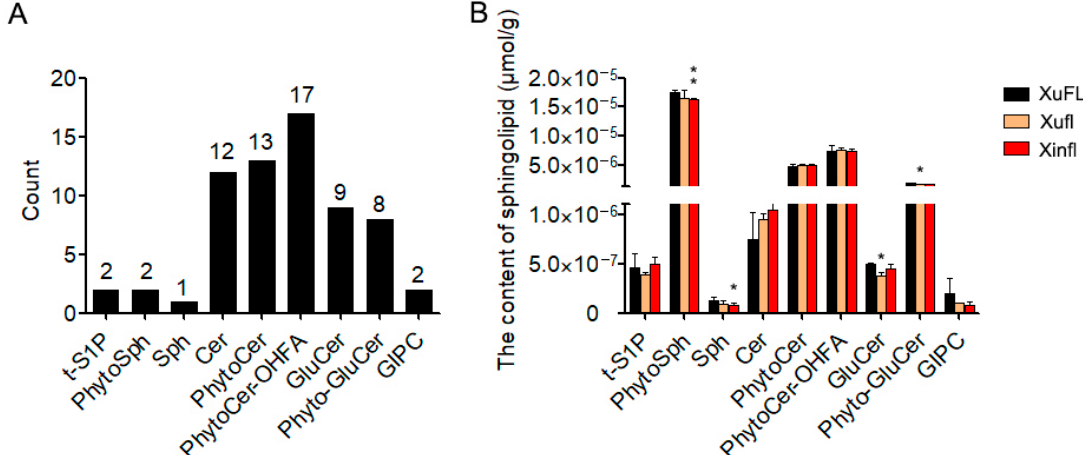
Figure 2. Sphingolipid classes in the 0-DPA ovules of cotton and their differences between wild-type and two mutants. ( A ) The number of classes and molecular species of sphingolipids detected in 0-DPA ovules. ( B ) The content of sphingolipid classes at the 0-DPA ovules of XuFL, Xufl , and Xinfl . Cer, ceramides; PhytoCer, phytoceramides; PhytoCer-OHFA, phytoceramides with hydroxylated fatty acyls; t-S1P, phytosphingosine-1-phosphate; Sph, sphingosines; PhytoSph, phytosphingosines; GluCer, glucosylceramides; Phyto-GluCer, phyto-glucosylceramides; GIPC, glycosyl-inositol-phospho-ceramides. XuFL, wild-type Xuzhou 142; Xufl , Xuzhou 142 lintless-fuzzless mutant; Xinfl , Xinxiangxiaoji lintless-fuzzless mutant. SD represents three biological repeats. Statistical data analysis was performed by the one-tailed student’s t -test. One asterisk and two asterisk indicate significant differences at p < 0.05 and p < 0.01, respectively.